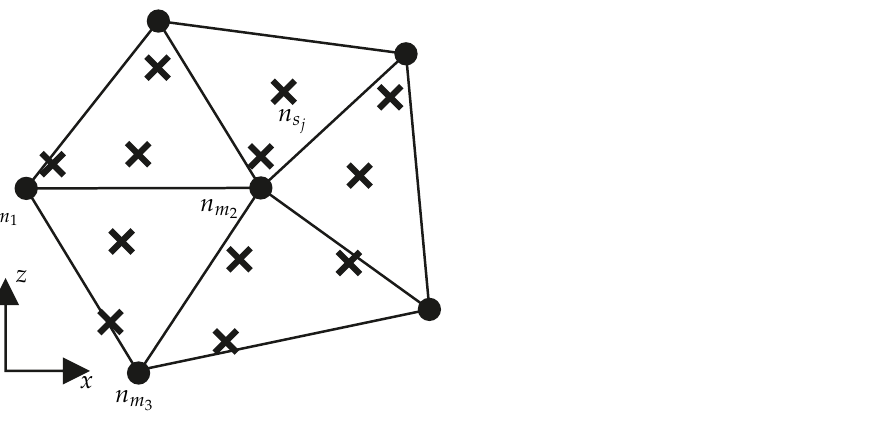
and the directly neighboring master nodes at time t i . 2